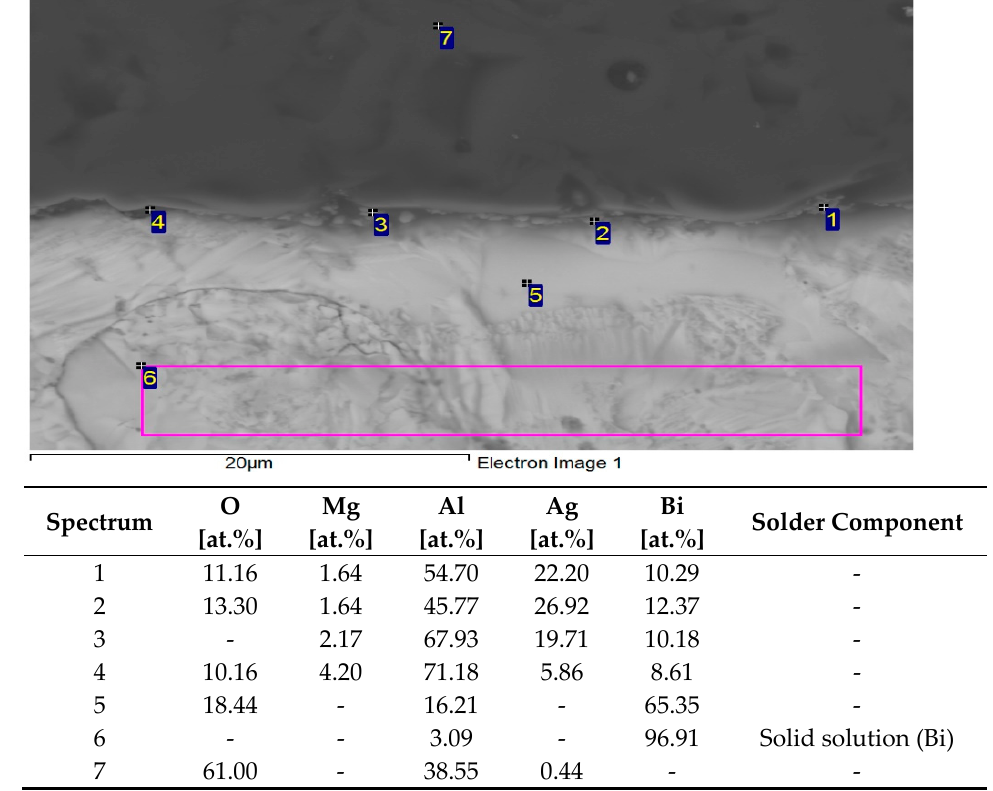
Figure 14. EDX point analysis of the Al 2 O 3 /Bi11Ag1Mg joint. The planar distribution of elements on the boundary is documented in Figure 15. The zone is closest to the interface between the Al 2 O 3 substrate and solder (spectrum 5). From the planar distribution, it is obvious that magnesium significantly contributes to Occurrence of a solid solution of (Bi) + Al 2 O 3 bond formation. The green color identifies the magnesium presence on the boundary. Magnesium is also partially diffused into the substrate zone.